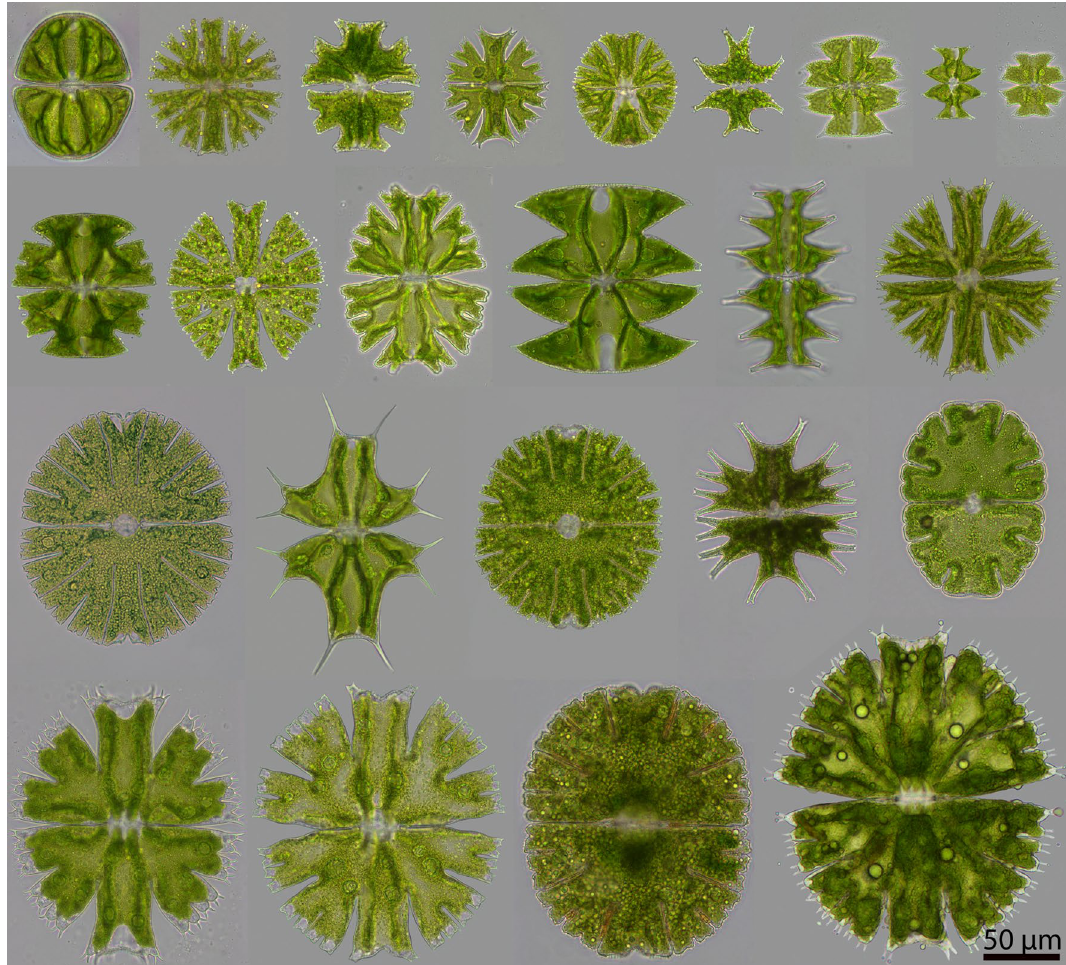
Figure 1. Size and morphological variability in Micrasterias . Microphotographs of 24 strains used in the experiment. From right to left: first line M. ralfsii, M. radiosa, M. crux-melitensis, M.radians, M. conferta, M. tropica, M. ceylanica, M. pinnatifida, M. decemdentata ; second line: M. truncata, M. novae-terrae, M. americana, M.laticeps, M. muricata, M. papilifera, M.thomasiana (K602), M. ceratofera, M. thomasiana (SCVK 8),